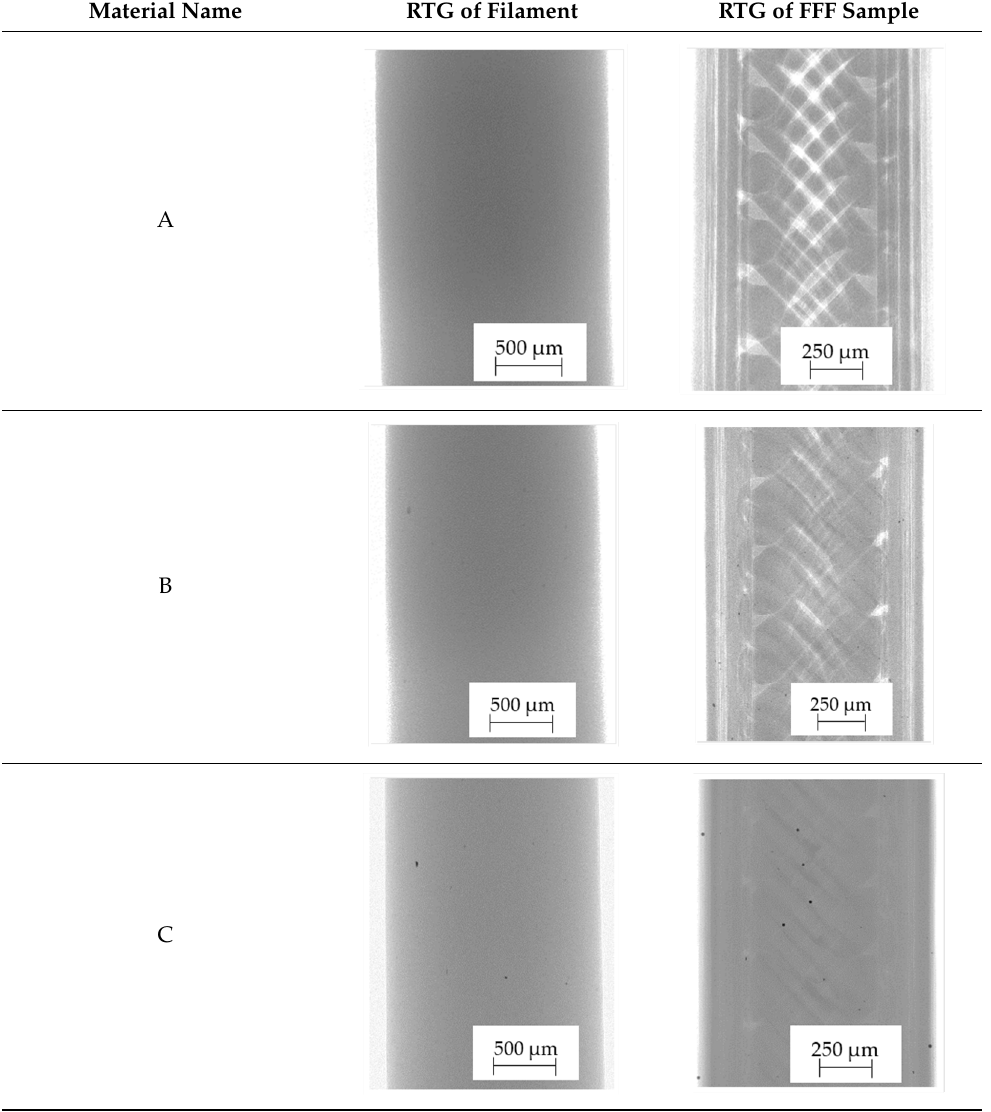
Table 3. Results of 2D digital radiography of filaments and samples manufactured additively.